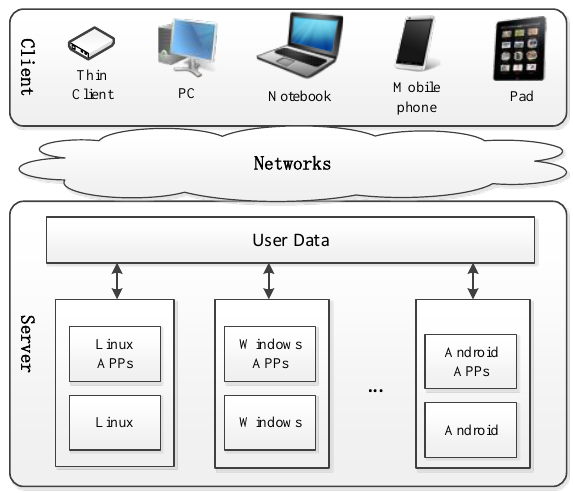
Figure 1. Transparent computing